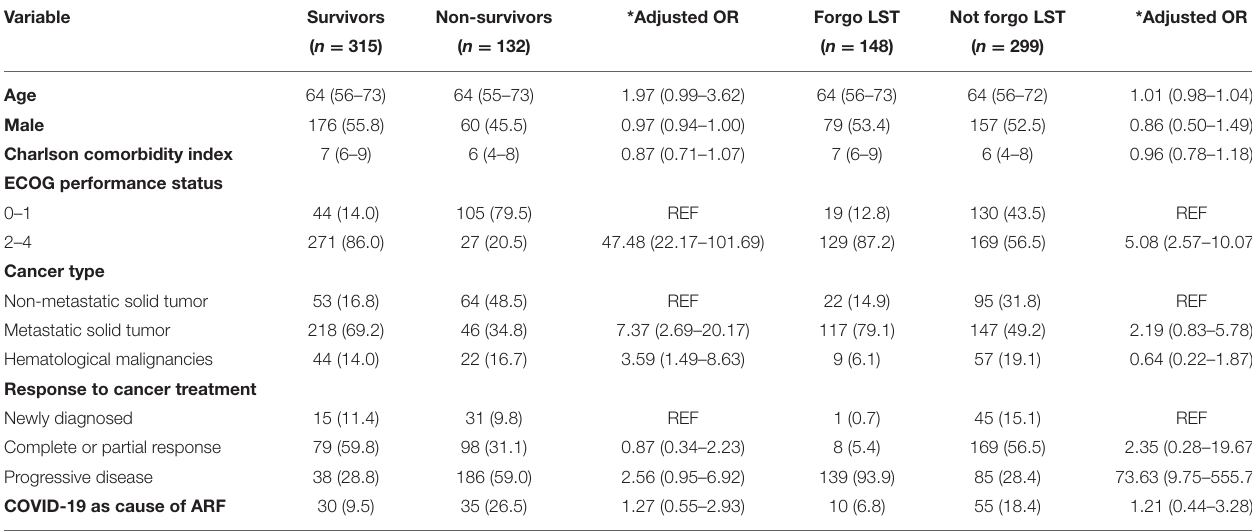
TABLE 2 | Multivariate analysis for in-hospital mortality and decisions to forgo life-sustaining therapies of critically ill patients with cancer admitted to ICU with acute respiratory failure.